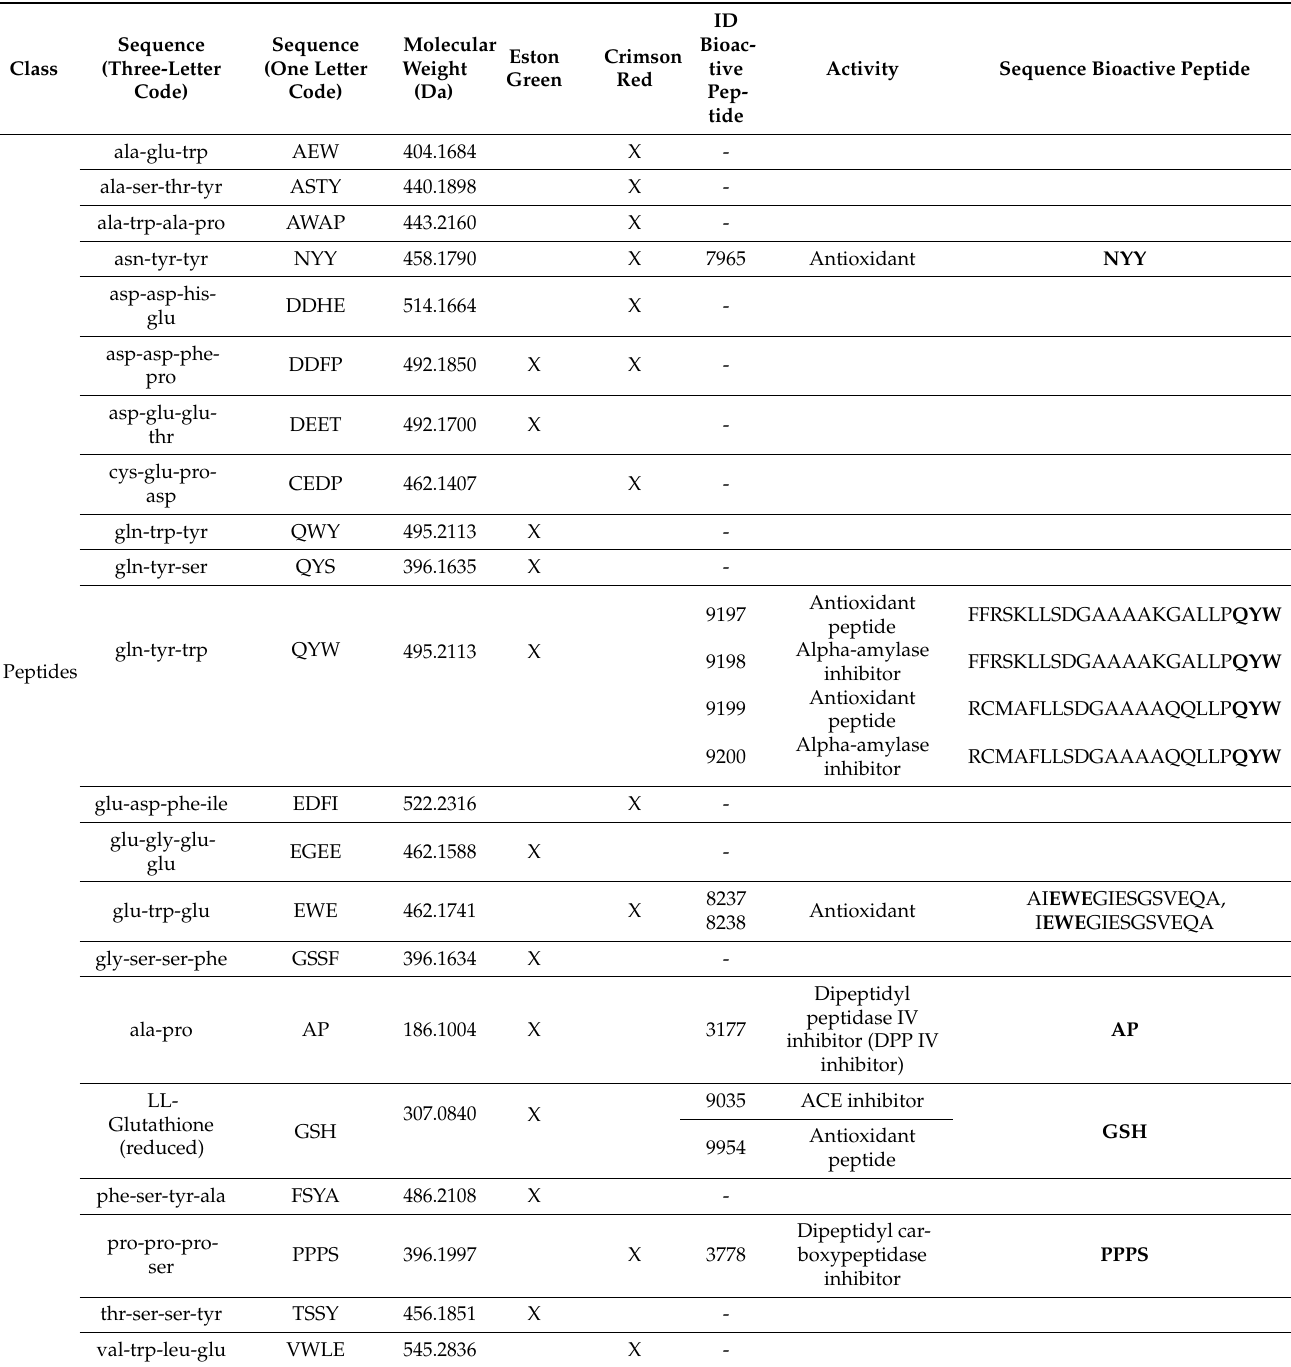
Table 4. Bioactive peptides that were found in water extract of Eston green and Crimson red lentil hulls (X: presence; empty cell: absence in the lentil cv.) after search performed in BIOPEP-UWM TM